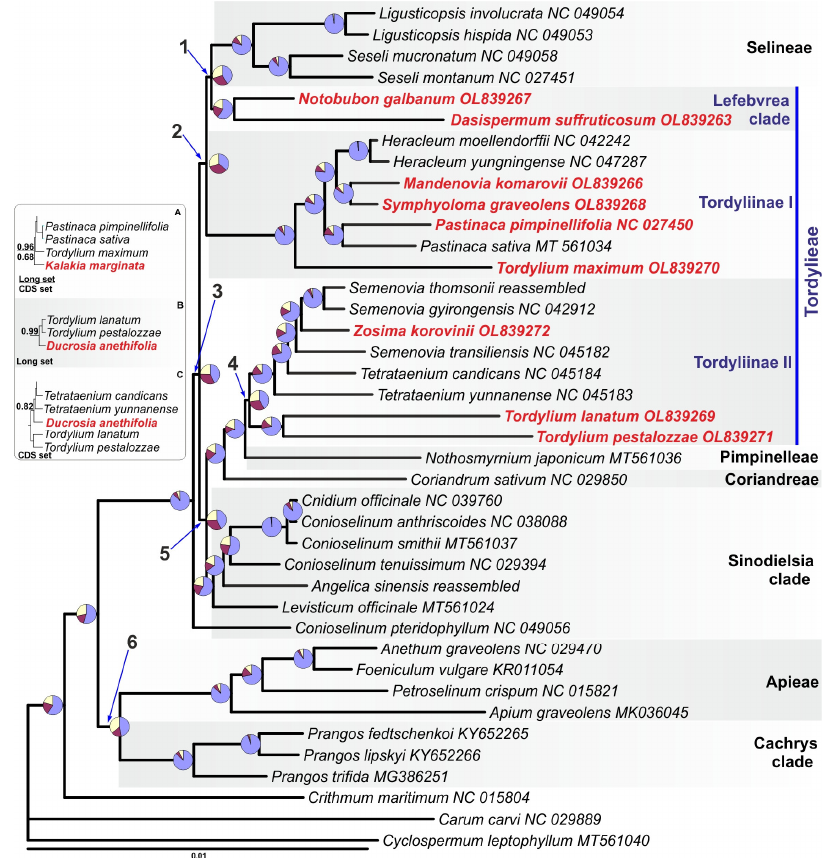
Figure 2. Maximum a posteriori probability tree (PP = 1) inferred with Bayesian analysis of complete plastome sequences from 40 representatives of the apioid superclade. Plastomes derived for this study are marked with red. Support for enumerated branches 1–6 is presented in Table 2; others gained the highest support in all analyses. The pie chart represents the site concordance (purple)/discordance (red and yellow) factor. The inset shows Kalakia ( A ) and Ducrosia ( B , C ) placement and support when included in Bayesian analyses of CDS ( A , C ) and long ( A , B ) data sets. ied (Table 2). Table 2. Support for branches 1–6 gained in phylogenetic analyses of CDS and full data matrices in unpartitioned and partitioned phylogenetic analyses. PP = posterior probability, aBayes = “ a la Bayes” support, BS = nonparametric bootstrap support, sCF/sDF = site concordance/discordance factor. Branch